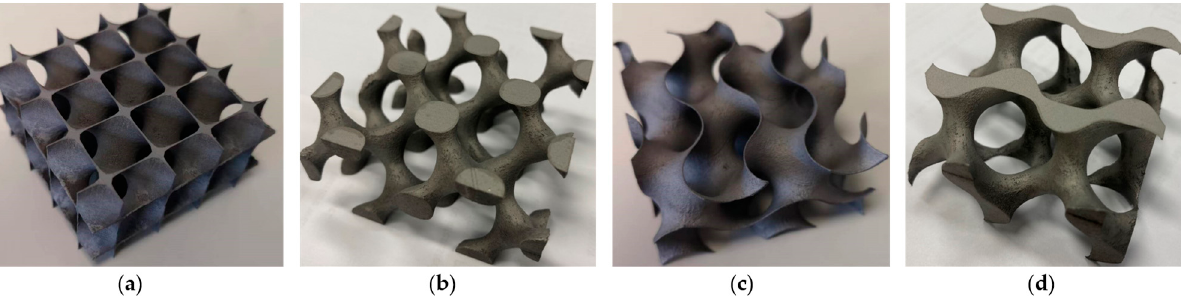
Figure 24. Examples of additively manufactured TPMS structures by SLM using stainless steel, which can be used for steady-state experiments: ( a ) Sheet-Diamond; ( b ) Solid-Diamond; ( c ) Sheet-Gyroid; ( d ) Solid-Diamond structures.